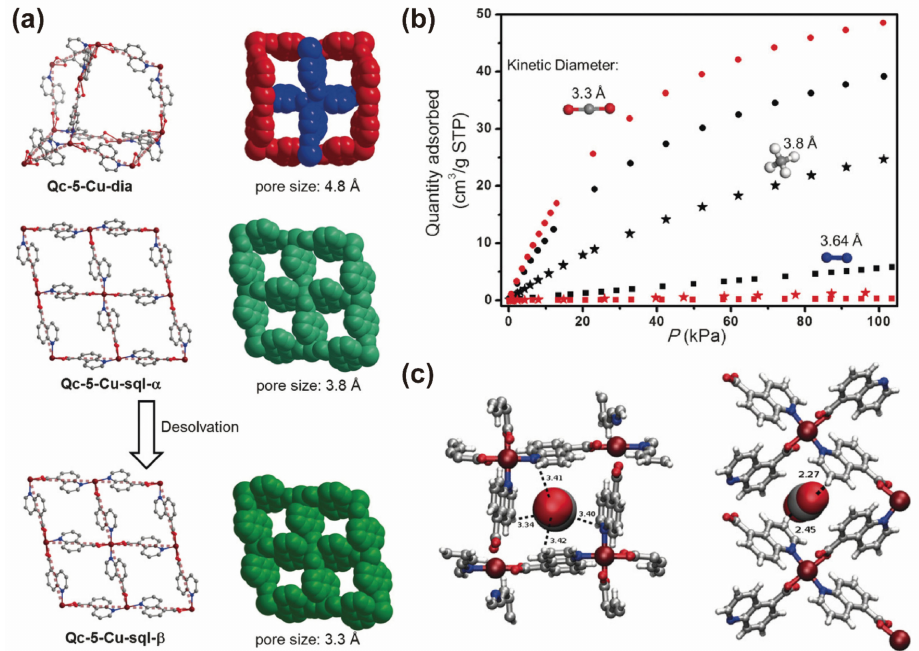
Figure 2. ( a ) Pore diameter tuning by supramolecular isomerism. ( b ) CO 2 (circle) and CH 4 (star) sorption isotherm for Qc-5-Cu-dia (black) and Qc-5-Cu-sql- β (red) at 293 K. ( c ) The binding